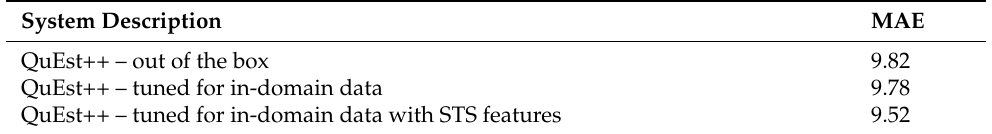
Table 2. MAE predicting the FMS for the Autodesk Data (low MAE indicate better performing system). System Description MAE QuEst++ – out of the